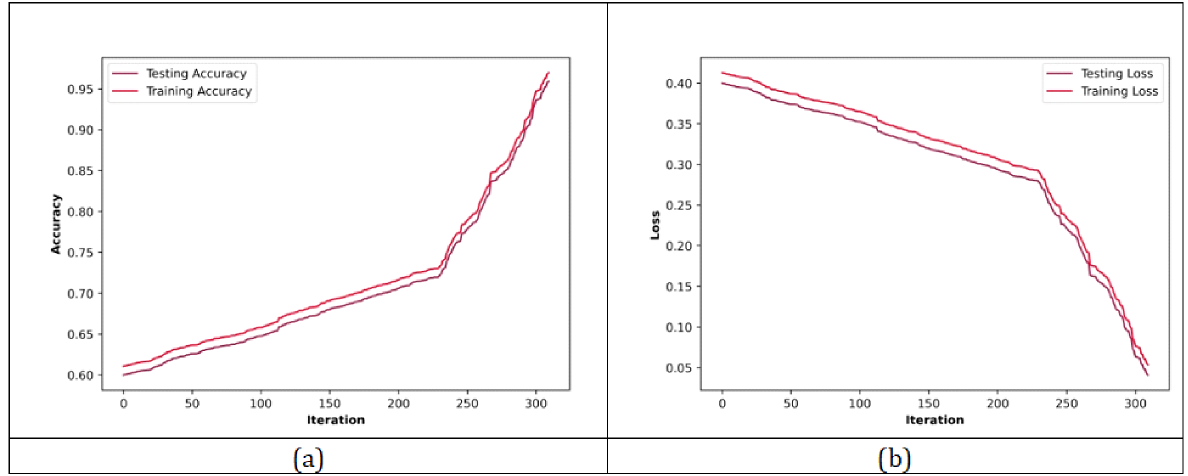
Figure 5. Performance analysis based on ( a ) accuracy and ( b ) loss for Sentiment Classification using Yelp 2013 dataset.